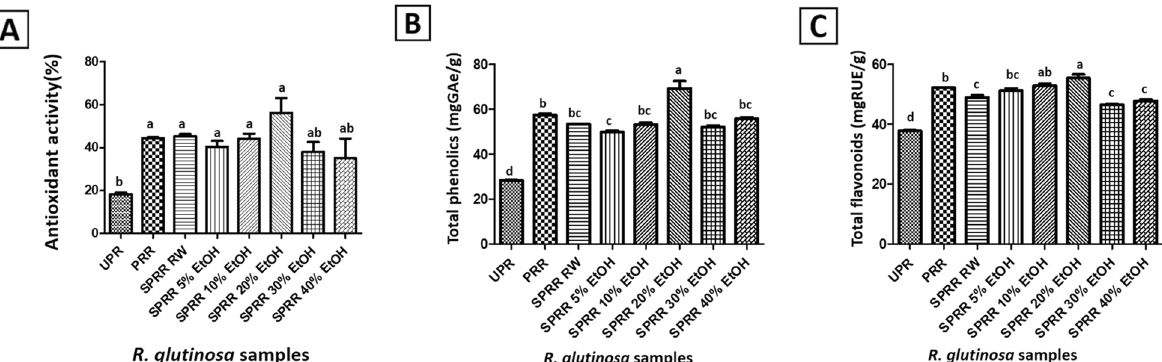
Fig. 7 Percentage of DPPH antioxidant activity, total phenolic, and total flavonoid content of all R. glutinosa sample extracts. a Antioxidant activity of R. glutinosa samples. b Total phenolics content of of R. glutinosa samples. c Total flavonoids content of R. glutinosa samples. * UPR Unprocessed R. glutinosa , PRR Processed R. glutinosa , SPRR Supplemented Processed R. glutinosa , RW Rice wine. Values are presented as means standard deviation. ± Same letters are not significantly different by Tukey’s test and p =